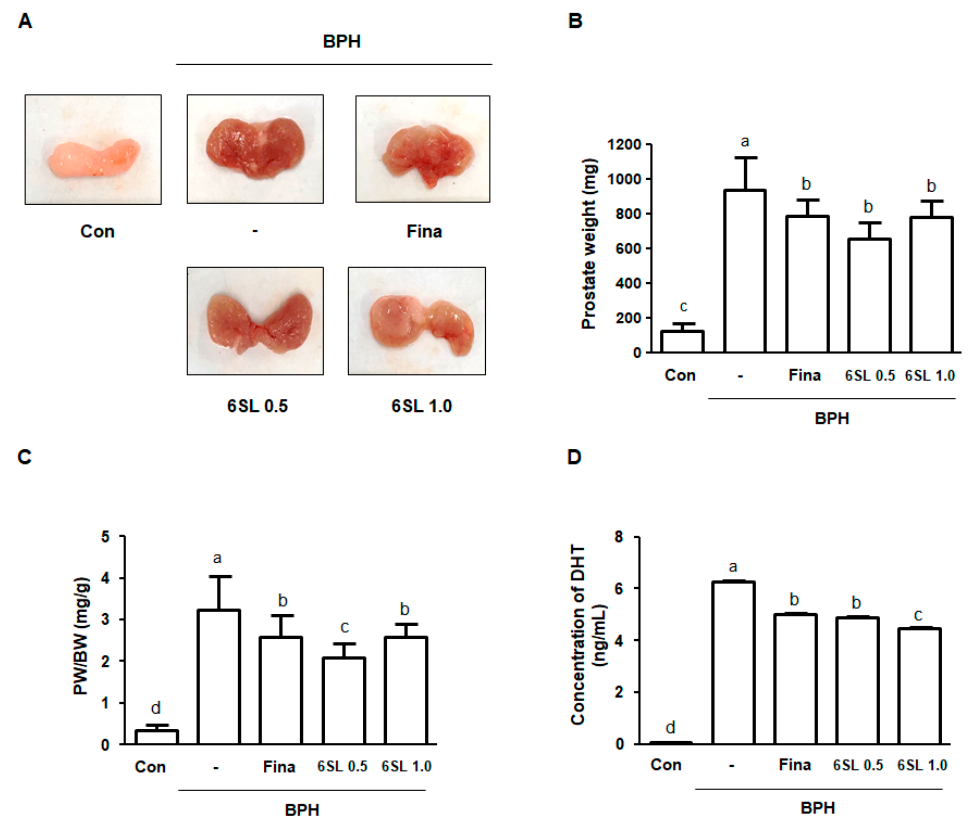
Figure 1. Effect of 6SL on enlarged prostate in a testosterone propionate (TP)-induced benign prostatic hyperplasia (BPH) rat model. ( A ) Representative images showing changes of prostatic tissues from each experimental group are detected. ( B ) Prostate weight (PW) and ( C ) prostate weight to body weight (PW/BW) ratio was measured and analyzed. Prostate weight to body weight (PW/BW) ratio = (Mean value of prostate weight from the experimental group / Mean value of body weight from the experimental group) × 1000. All data are mean ± SD ( n = 8 per group). ( D ) The concentration of DHT was analyzed using ELISA kit. All data are mean ± SD ( n = 4). Values with different letters indicate significant differences, p < 0.05. Con; control animals, BPH; rats with BPH induction, Fina; rats with BPH orally administrated 5 mg / kg finasteride, 6SL 0.5 and 1.0; rats with BPH intraperitoneally administrated 0.5 or 1.0 mg / kg